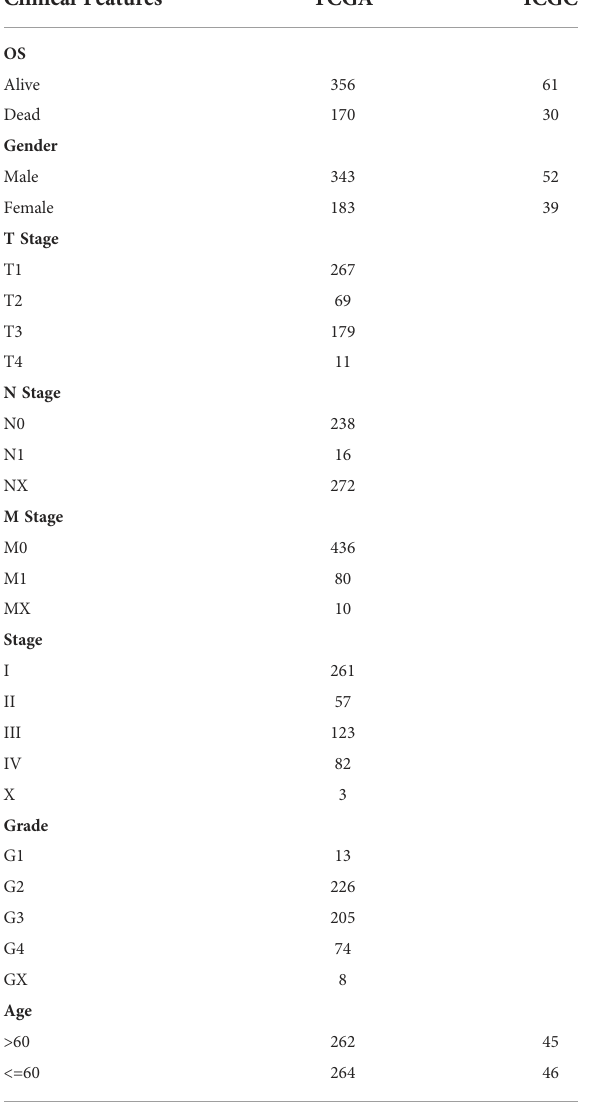
TABLE 1 Clinical information of the sample in TCGA and ICGC datasets. Clinical